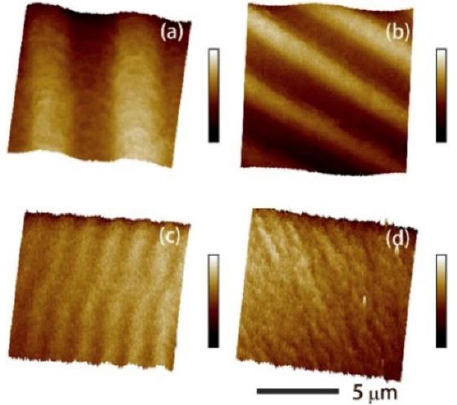
Figure 15. ( a ), ( b ), ( c ) and ( d ) are the surface magnetic domains of (480 nm Fe-Ga), (30 nm Fe-Ga/30 nm Fe- Ni) 8 , (16 nm Fe-Ga/16 nm Fe-Ni) 15 and (8 nm Fe-Ga/8 nm Fe-Ni) 30 films. Reprinted with permission from